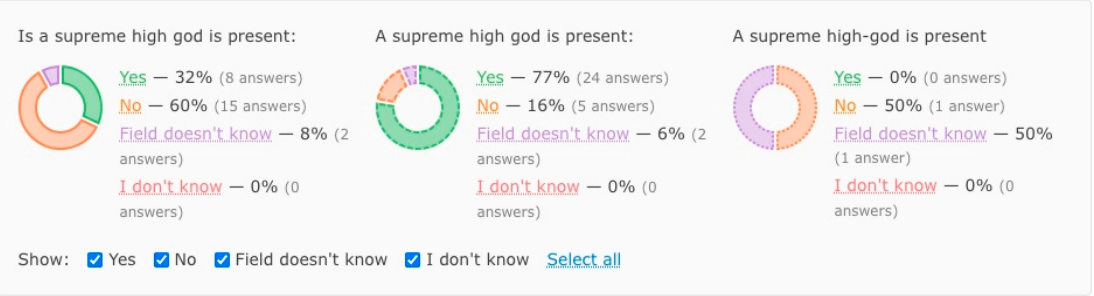
Figure 4. DRH visualization for the query “ A supreme high god is present ” from 3000 BCE to 99 CE focusing on the regions of mainland Greece, southern Italy and Sicily, and western Anatolia. The pie charts represent the “Group”, “Place”, and “Text” polls, ordered.